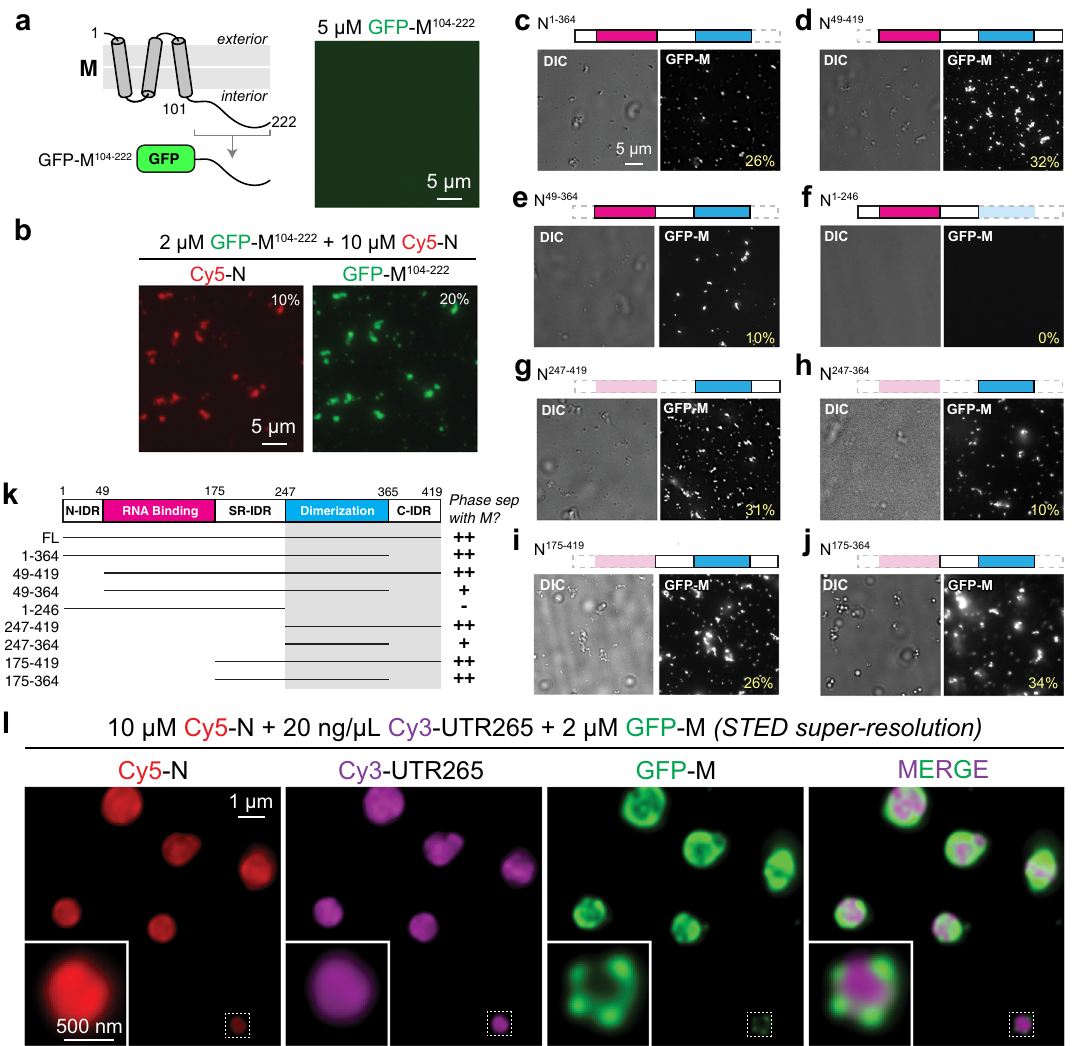
Fig. 7 SARS-COV-2 M protein promotes N protein phase separation independent of RNA. a Left: schematic of SARS-CoV-2 M protein showing its three transmembrane helices and C-terminal domain, and the GFP-M 104 – 222 fusion construct. Right: fl uorescence image of 5 µ M puri fi ed GFP-M 104 – 222 . Scale bar, 5 µ m. b Fluorescence images of condensates formed upon mixing N (10% Cy5-labeled) with GFP-M 104 – 222 . Scale bar, 5 µ m. GFP alone does not induce condensation of N protein (see Supplementary Fig. 9d). c – j Representative DIC and fl uorescence images of mixtures of 2 µ M GFP-M 104 – 222 with N protein values indicate the percentage of total RNA fl uorescence within condensates. Scale bar, 5 µ m. k Summary of phase separation behavior of N protein truncations when mixed with GFP-M 104 – 222 . + indicates 1 – 15% of GFP-M 104 – 222 fl uorescence within condensates; ++ indicates 16% or higher. l Representative STED super-resolution images of three-component condensates formed upon mixing 10 µ M N protein, 20 ng/ µ L UTR265, and 2 µ M GFP- M 104 – 222 . Enlarged images show one submicron condensate with N protein/UTR265 and N protein/GFP-M 104 – 222 at the periphery. Scale bar, 1 µ m for original image and 500 nm for enlarged fi